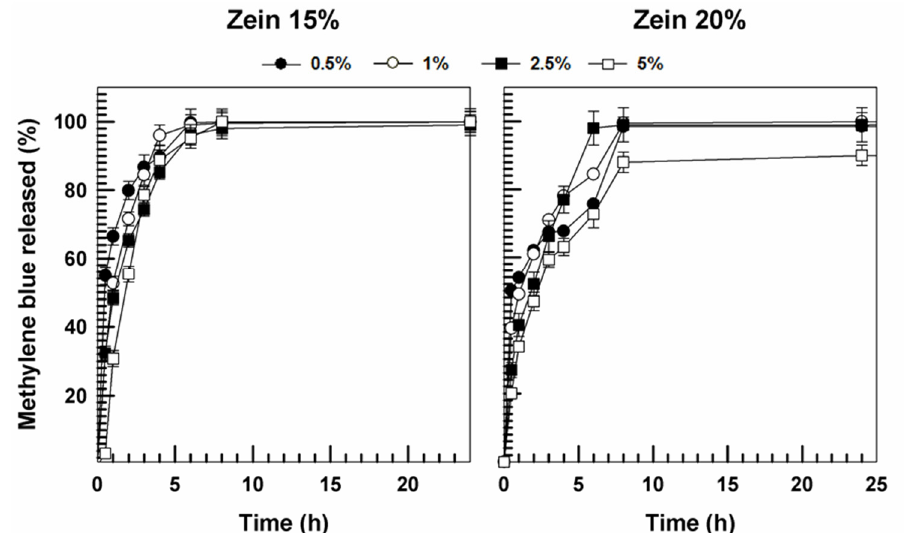
Figure 14. Release profile of methylene blue from zein gels (15%, 20% w/v ) as a function of the amount of entrapped drug and time. Values represent the mean of three different experiments ± standard deviation.